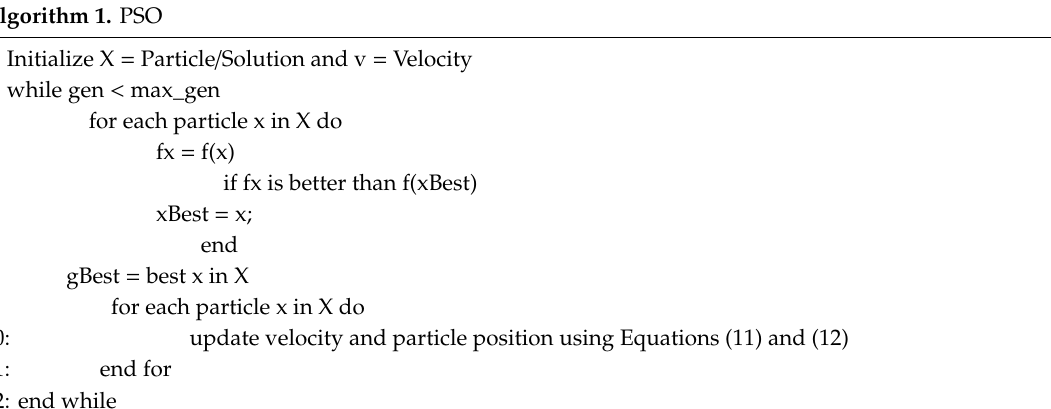
Figure 6. Flowchart of the optimal value finding. Algorithm 1.